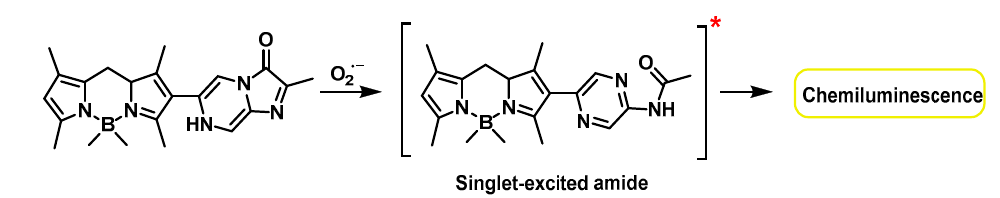
Murthy’s group found that hydrocyanines could be used to detect the superoxide